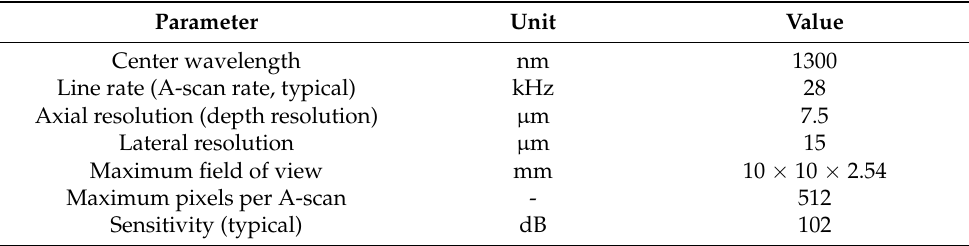
Table 6. Specifications of the spectral domain OCT system. Parameter Unit Value Center wavelength nm 1300 Line rate (A-scan rate, typical) kHz 28 Axial resolution (depth resolution) µ m 7.5 Lateral resolution µ m Maximum field of view mm Maximum pixels per A-scan - Sensitivity (typical) dB